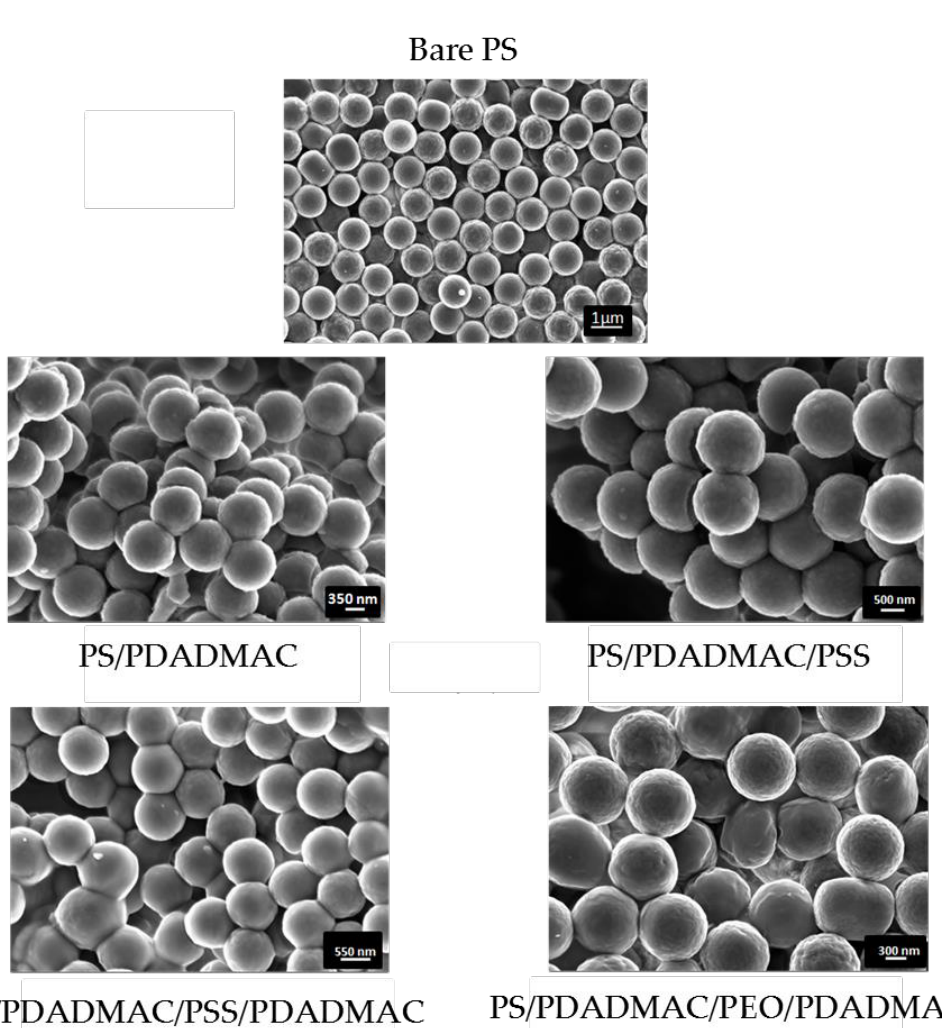
Table 1. Average (± S.D.) particle diameters of the latex particles investigated. Particle